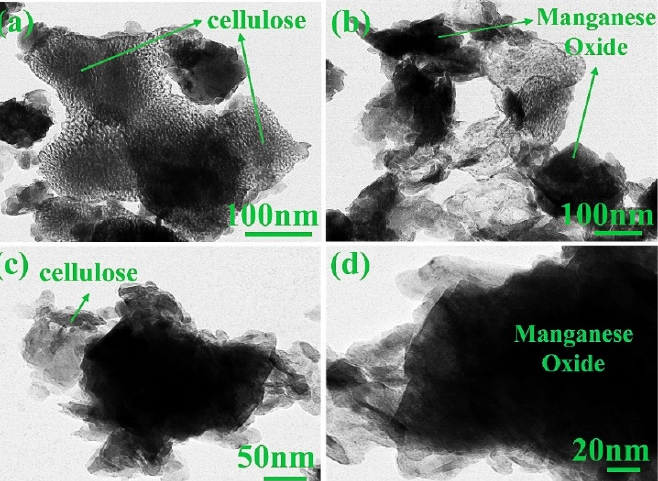
Figure 9. FE-TEM images of MnO 2 @CE at the magnification of ( a ) 100 nm, ( b ) 100 nm, ( c ) 50 nm, and ( d ) 20 nm.